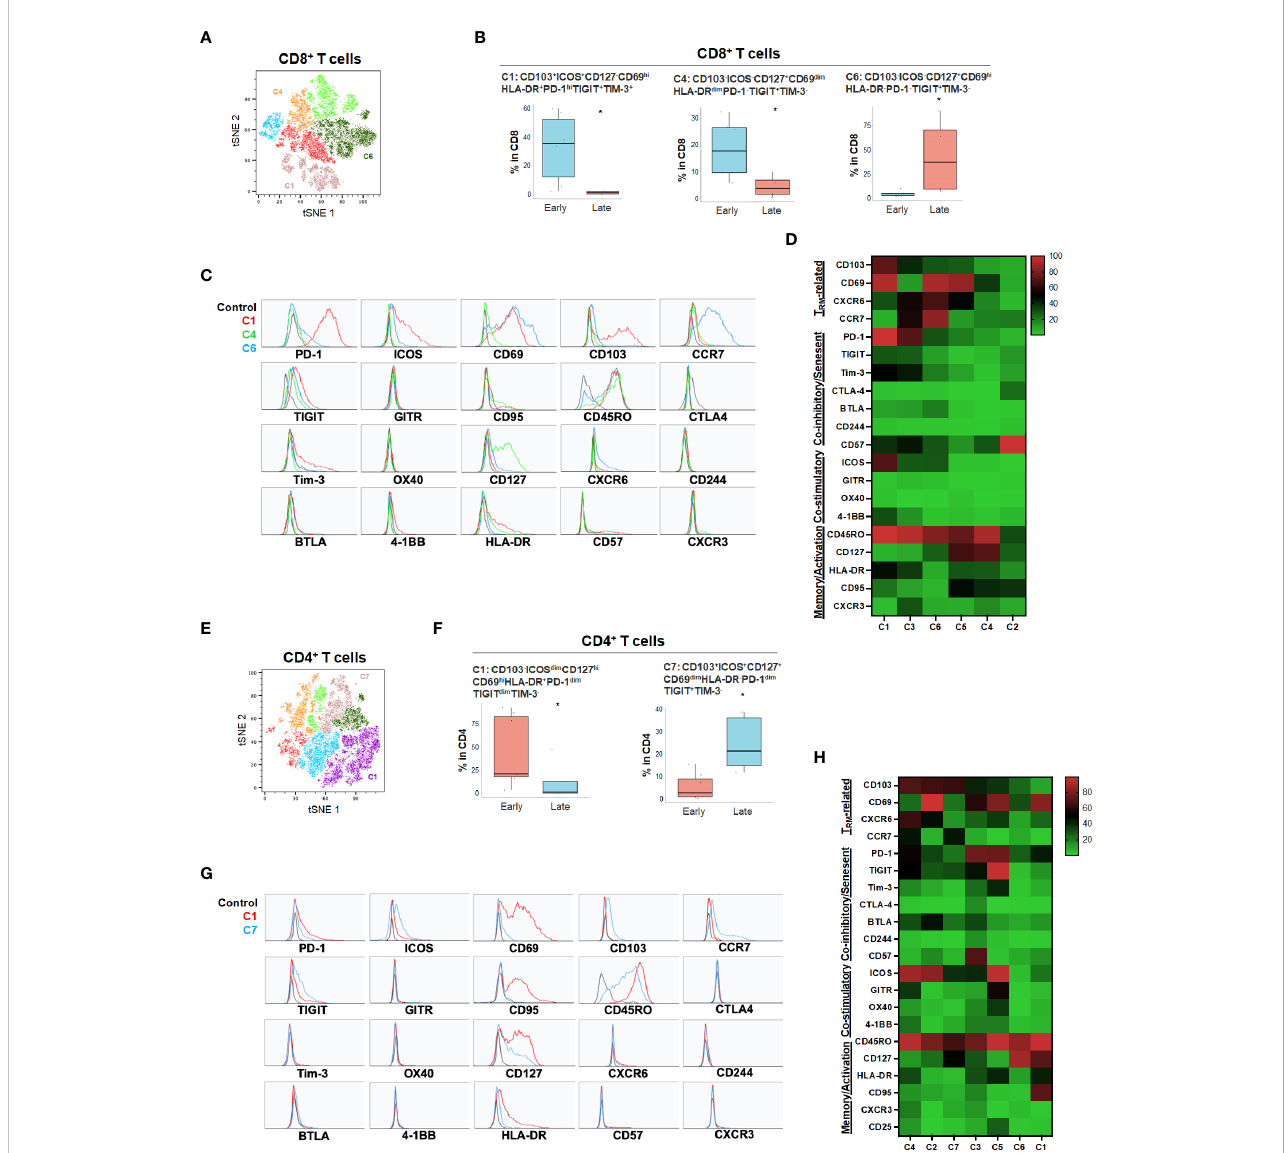
FIGURE 4 HCC disease stage and effect on T cell phenotypes. (A) tSNE projection of CD8+ T cells showing 6 manual-gated clusters identi fi ed from early stage (n=6) and late stage (n=4) HCC patients. Signi fi cantly enriched clusters in early stage (C1, C4) and late stage (C6) HCC patients are labeled. (B) Boxplots showing percentage of early stage-enriched CD8+ T cell clusters C1 and C4 and late stage-enriched cluster C6 in HCC patients. *p < 0.05, Kruskal- Wallis test. (C) Histograms showing the individual marker expression of early stage-enriched CD8+ T cell clusters C1 (red), C4 (green), and late stage- enriched cluster C6 (blue) in HCC patients. (D) Expression of TRM-related markers, co-inhibitory/senescent markers, co-stimulatory markers and memory/activation markers in 6 clusters of CD8+ T cells is shown in heatmap which is arranged based on the expression level of CD103. (E) tSNE projection of CD4+ T cells showing 7 manual-gated clusters identi fi ed from early stage (n=7) and late stage (n=5) HCC patients. Signi fi cantly enriched clusters in early stage (C1) and late stage (C7) HCC patients are labeled. (F) Boxplots showing percentage of early stage HCC enriched CD4+ T cell cluster C1 and late stage HCC enriched cluster C7. *p < 0.05, Kruskal-Wallis test. (G) Histograms showing individual marker expression of early stage HCC enriched CD4+ T cell cluster C1 (red) and late stage HCC enriched cluster C7 (blue). (H) Expression of TRM-related markers, co-inhibitory/ senescent markers, co-stimulatory markers and memory/activation markers in 7 clusters of CD4+ T cells is shown in heatmap which is arranged based on the expression level of